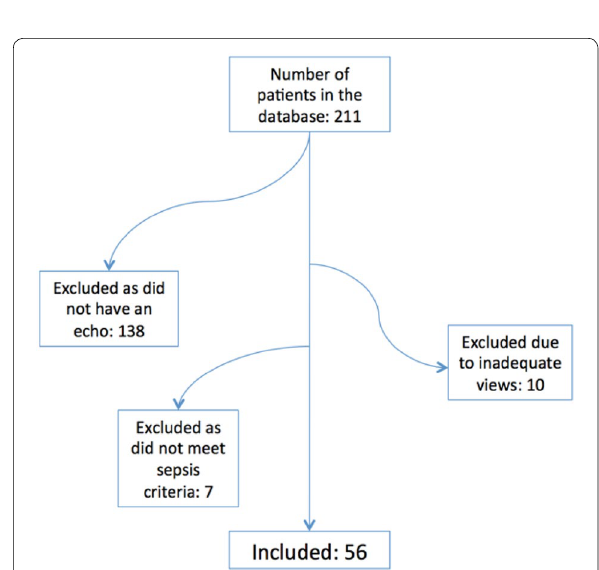
Fig. 2 Study design: patients included in